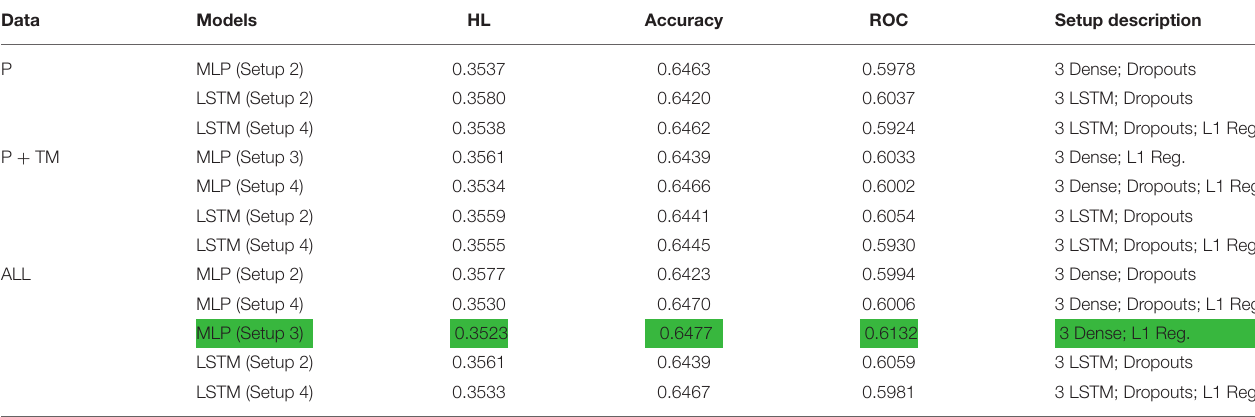
TABLE 2 | Feature ablation test results for the two deep learning methods (MLP, LSTM) and their used baseline setups with their corresponding HL, Accuracy and ROC scores for the three subsets of the FDV event sequence dataset: P refers to the fixed field data, TM refers to the text mining data and ALL refers to the fixed field, text mined and NSW Health data (best results are highlighted in green).